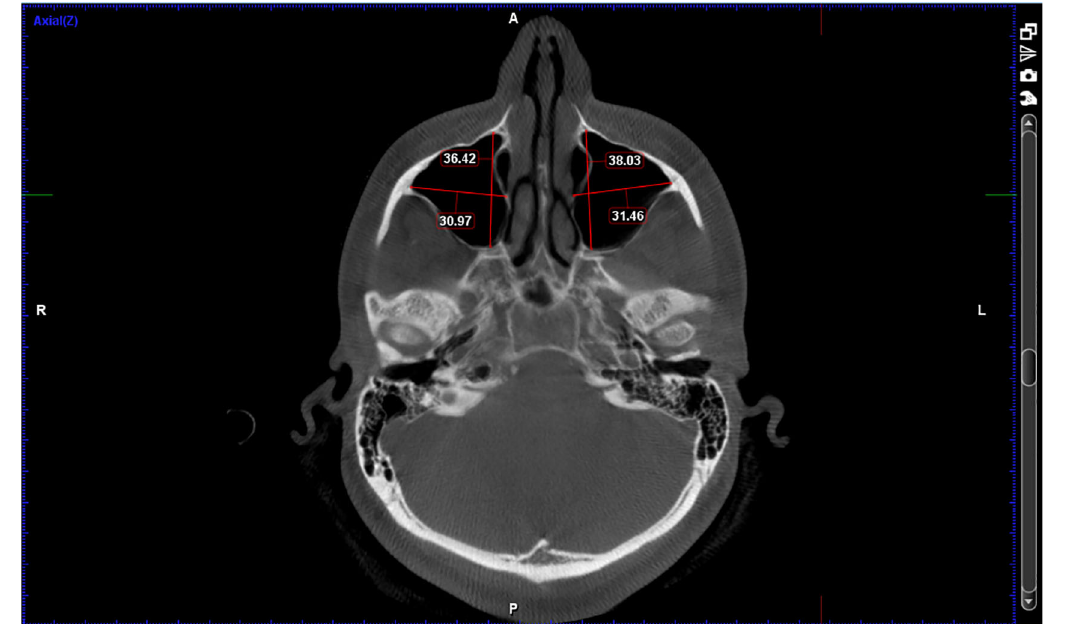
Figure 2. Width of the maxillary sinus (Mediolateral distance) and Depth of maxillary sinus (Anteroposterior distance).